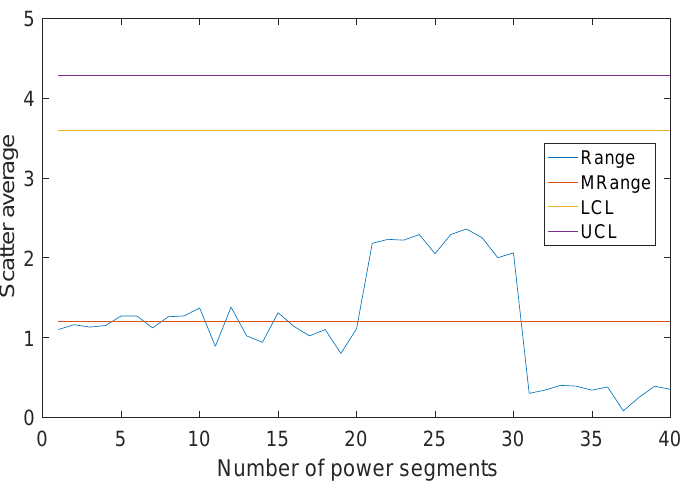
Figure 9. Horizontal comparison control chart of four